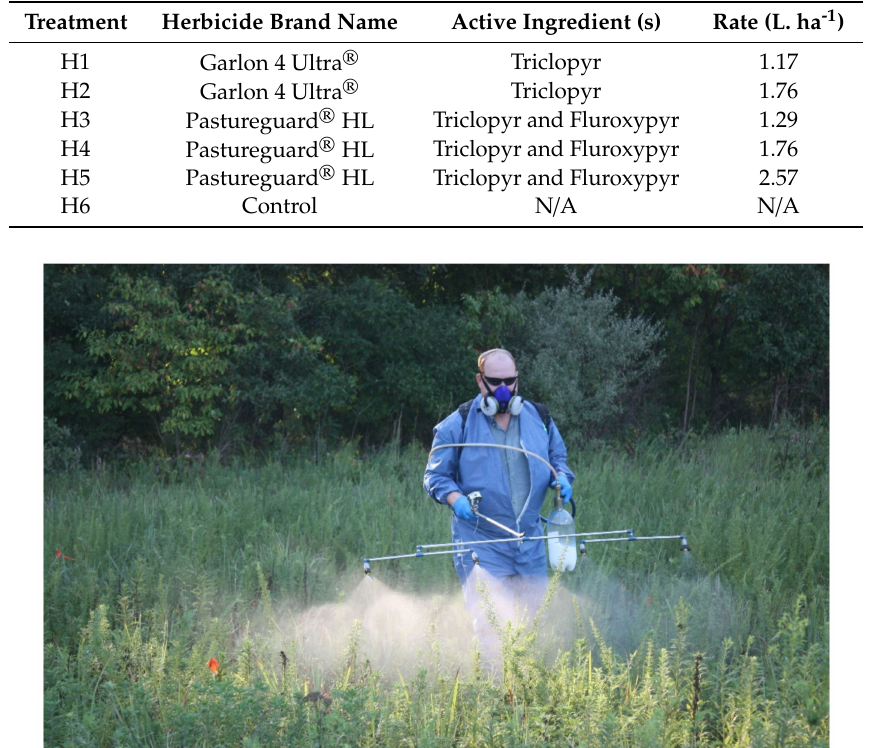
Table 3. Summary of herbicide treatments by brand name, active ingredient and concentration in liters per hectare for the plots treated in summer 2012.